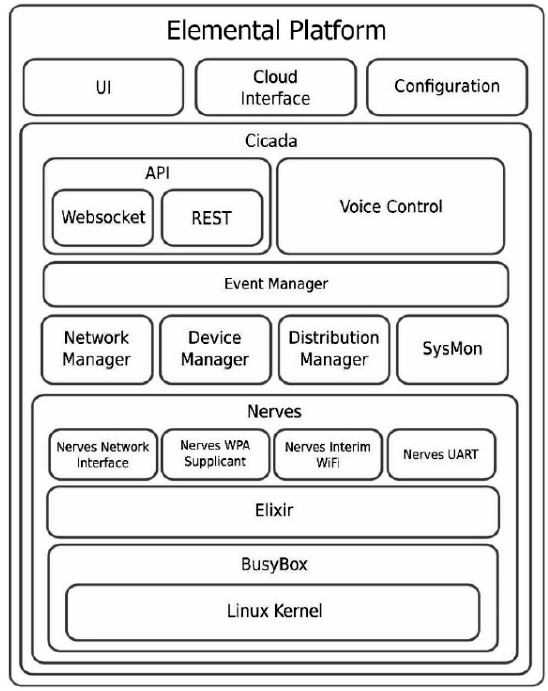
Figure 5. Elemental platform firmware architecture.